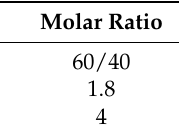
Figure 8. Flow chart of the preparation process SiO 2 layers using MTES and TEOS.